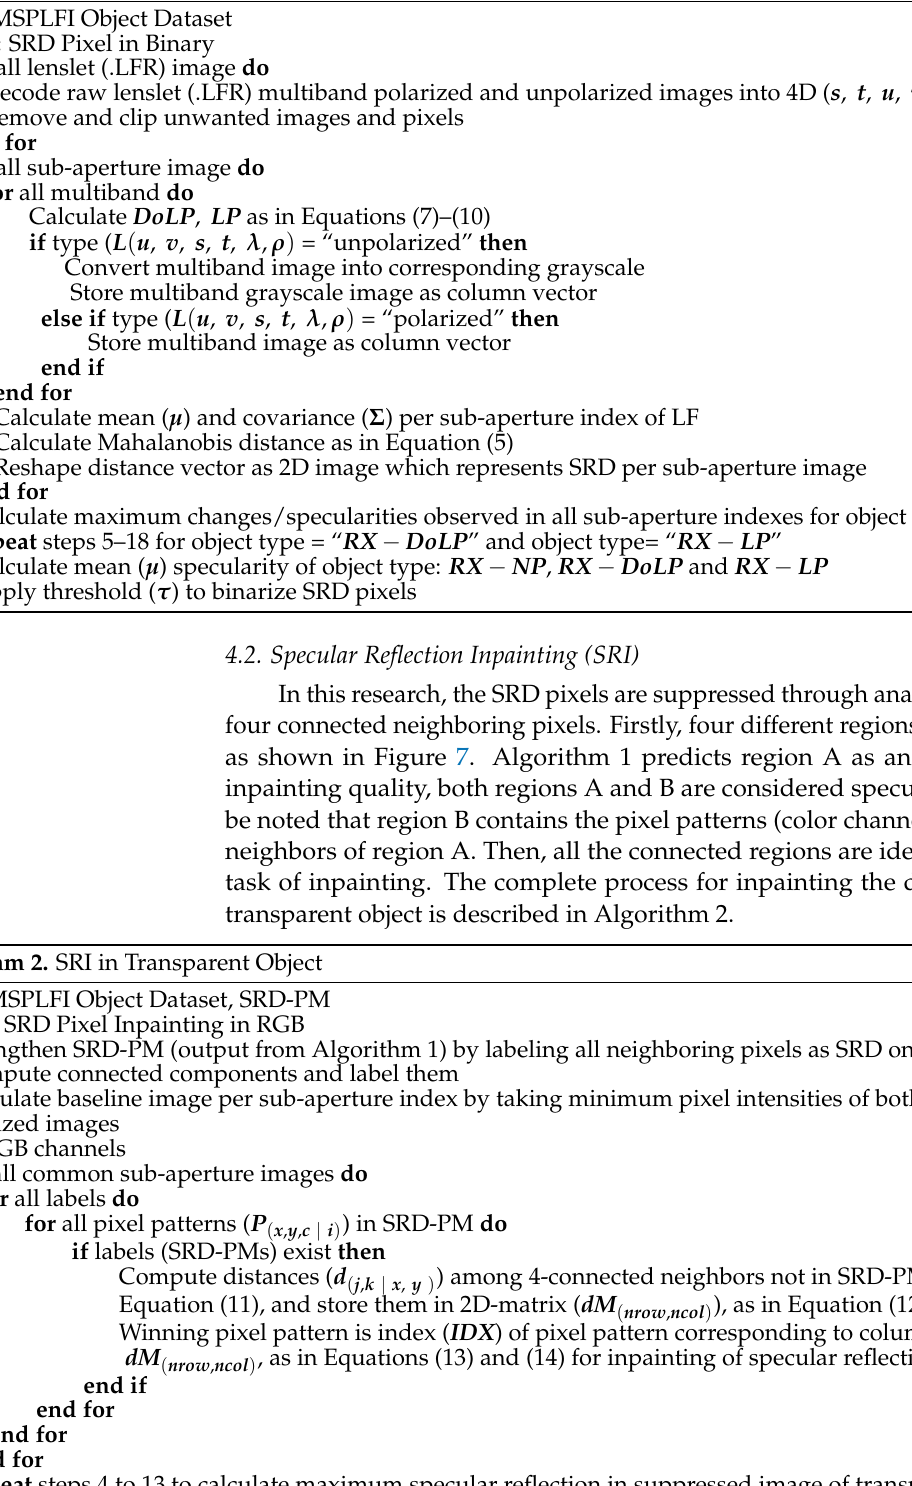
Algorithm 1. SRD in Transparent Object